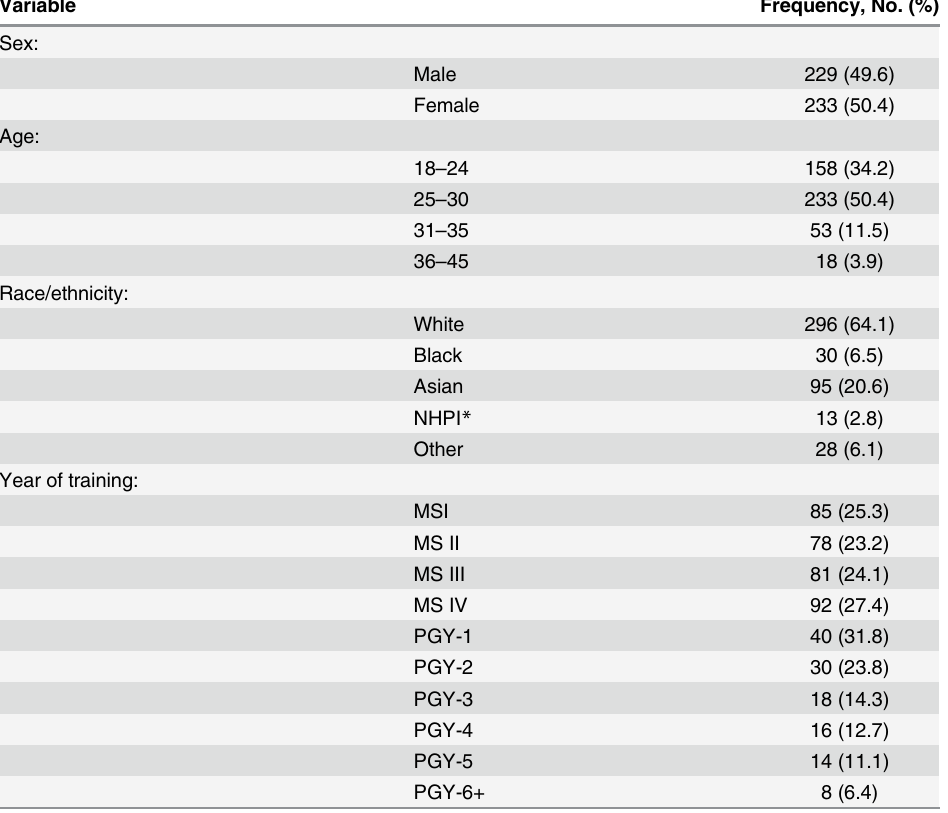
Table 1. Characteristics of the study